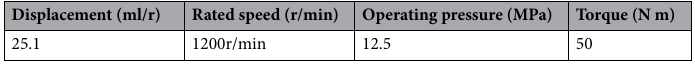
Table 1. Main characteristic parameters.